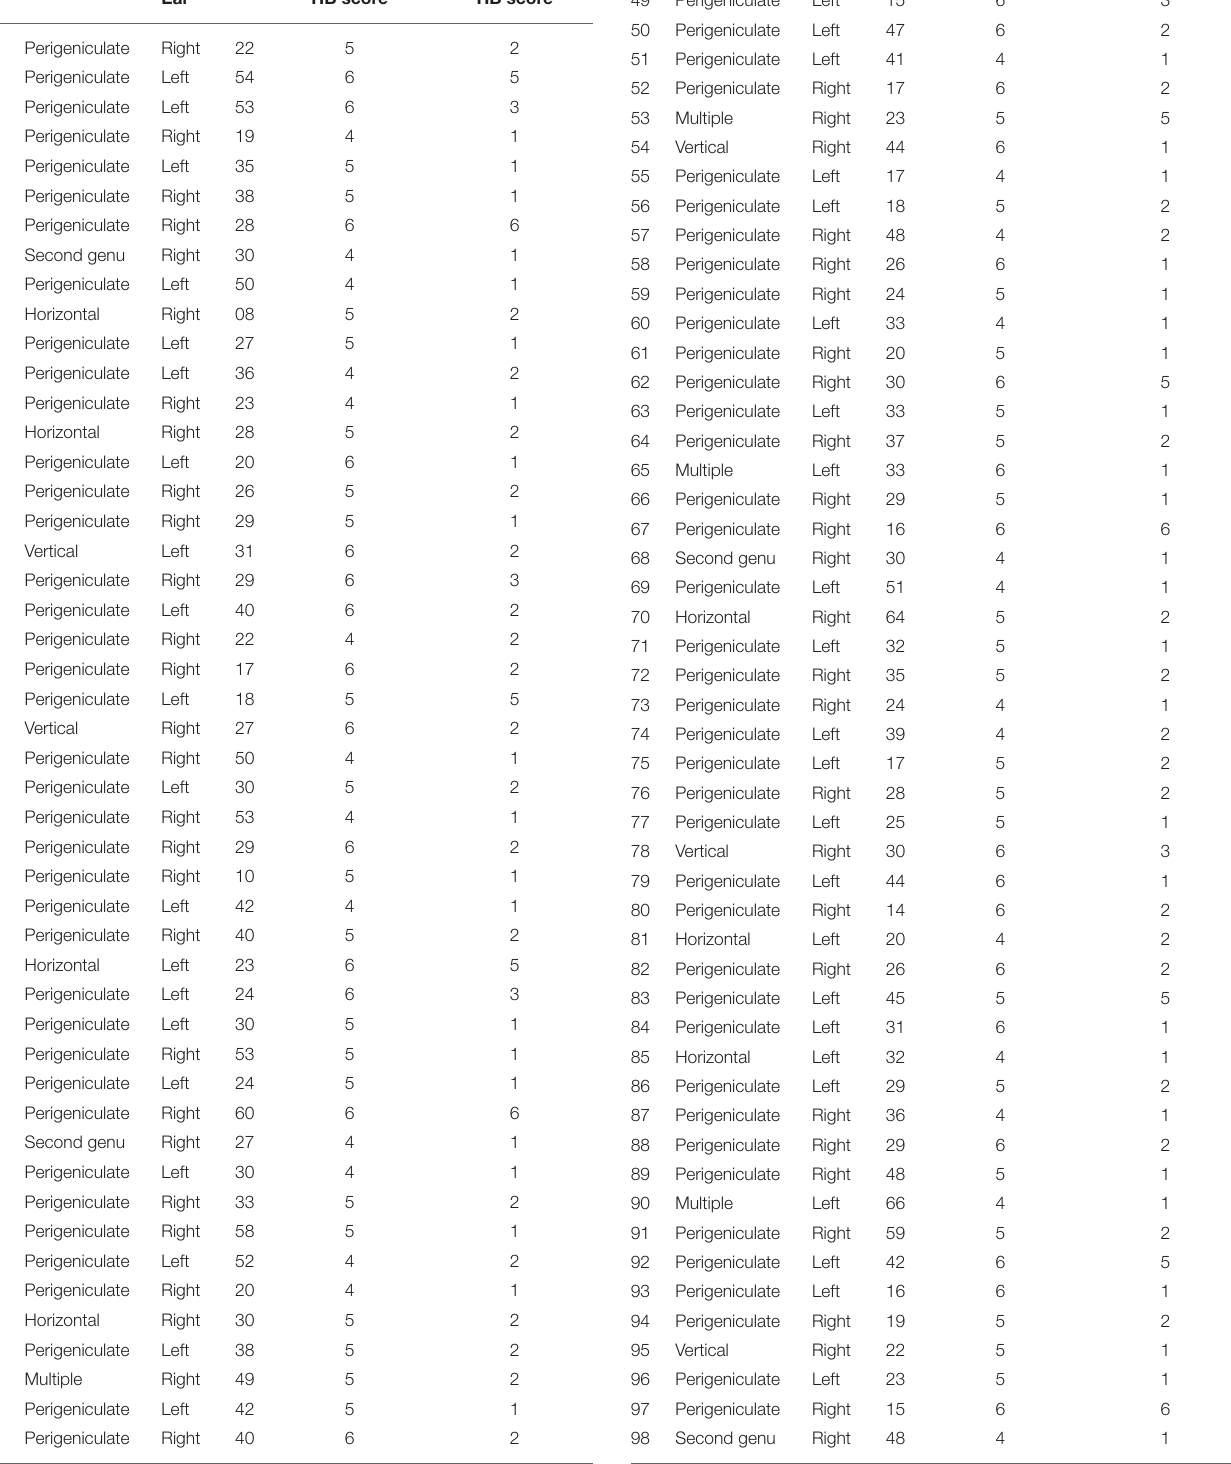
TABLE 1 | One hundred forty-one patients with House-Brackmann (HB) grades HB6, HB5, and HB4 facial weakness after temporal bone fracture—sites of fracture and pre- vs. post- operative HB